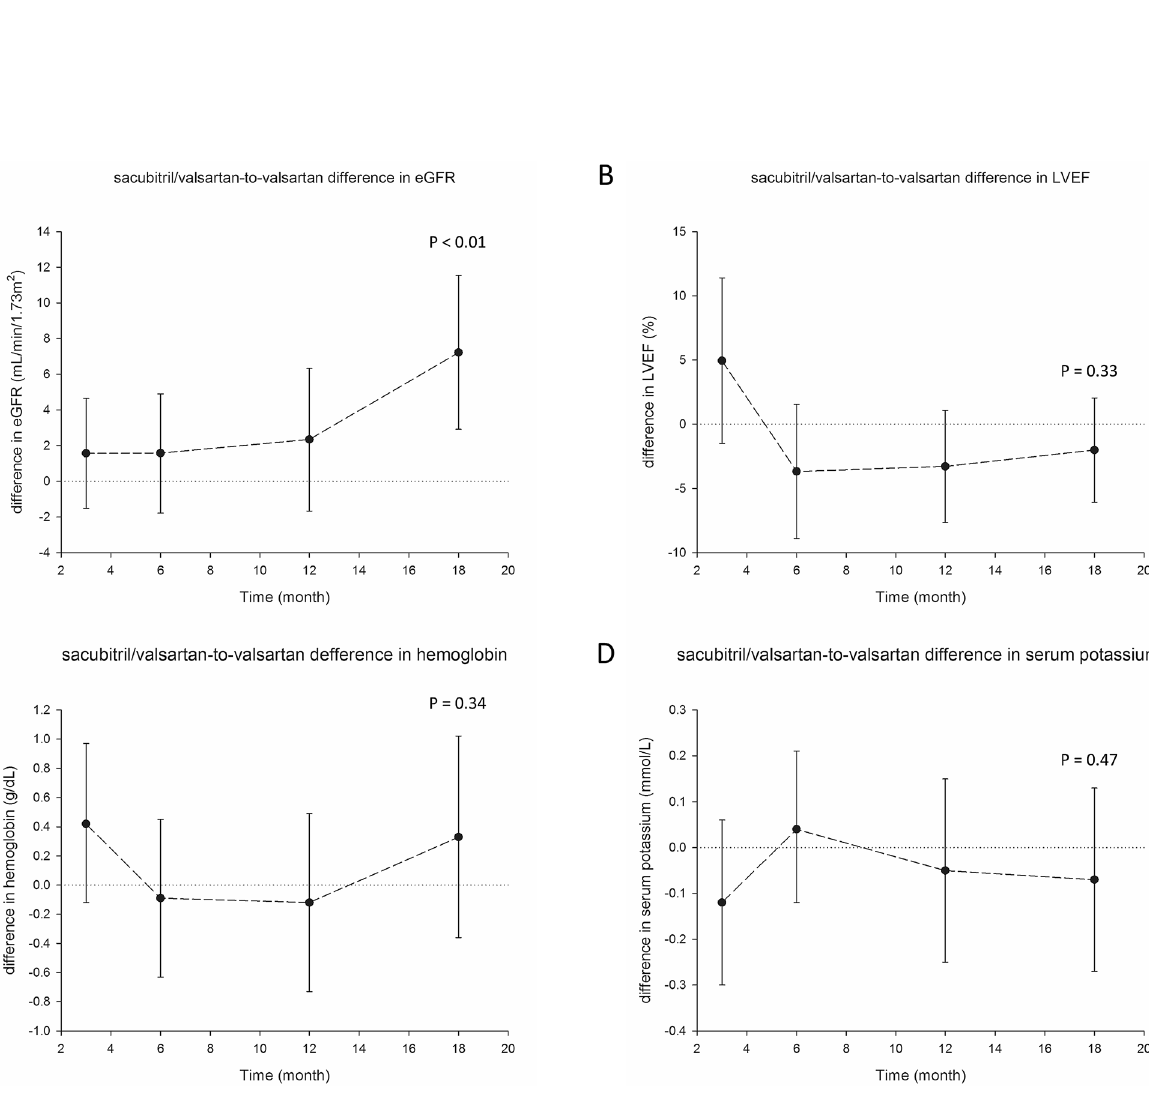
Figure 1. Difference of laboratory measurements and LVEF between patients on sacubitril/valsartan and valsartan. Difference of eGFR was calculated as sacubitril/valsartan group–valsartan group. eGFR, estimated glomerular filtration rate; LVEF, left ventricular ejection fraction. P value calculated by generalized estimating